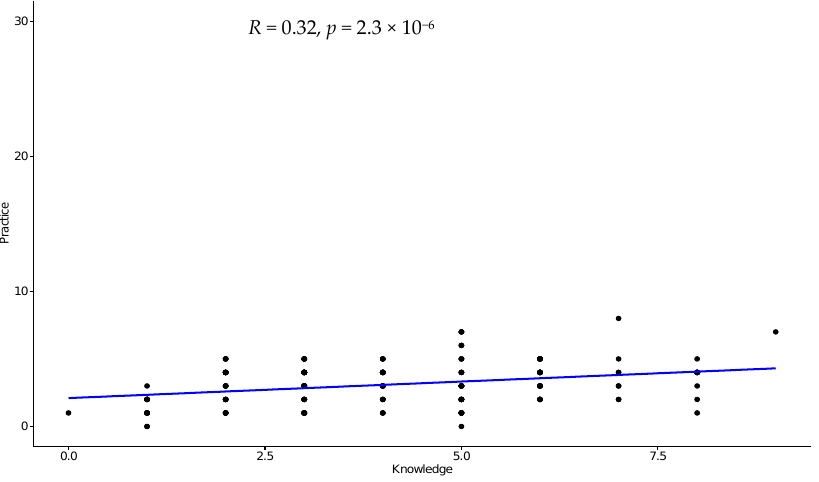
Figure 1. Scatter plot with regression line to show the correlation between knowledge and attitude. There is a statistically significant positive weak correlation between knowledge and attitude (R = 0.26).